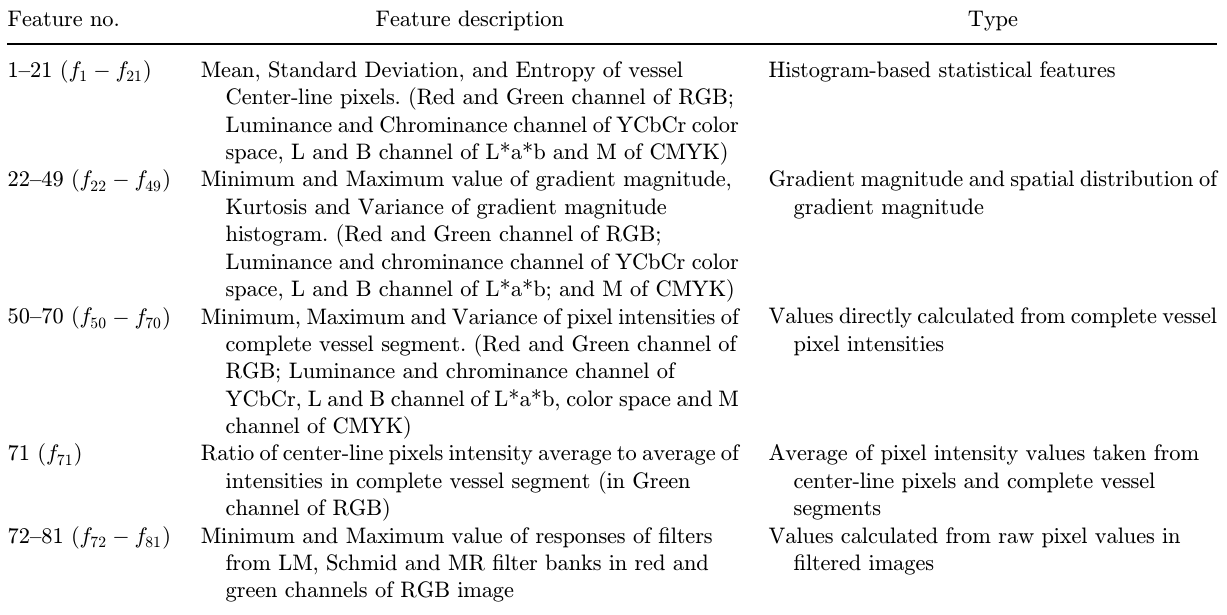
Table 1. Details of feature